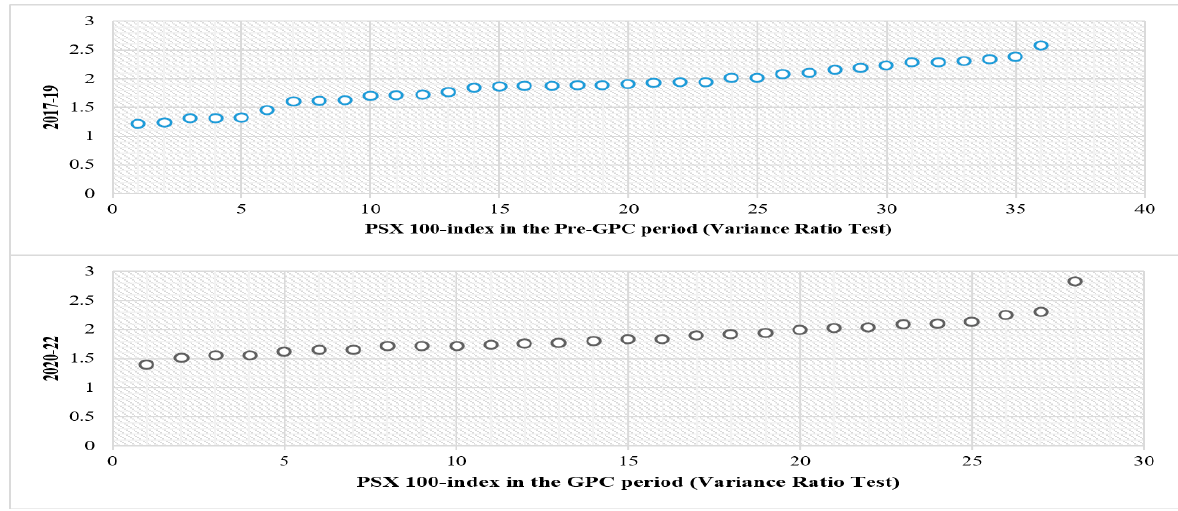
Figure 4. Informational Efficiency in the Pre-GPC period and GPC